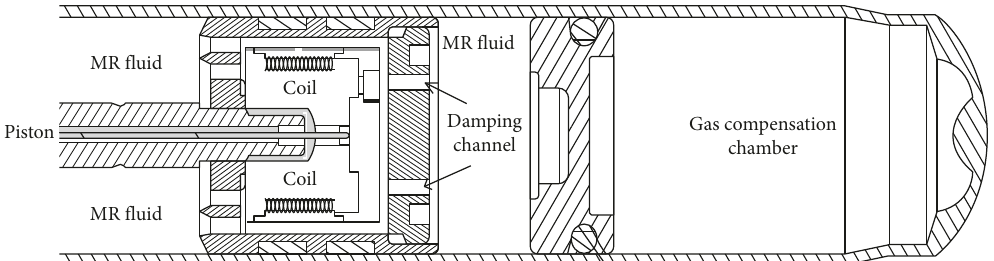
Figure 2: Magnetorheological damper structure.